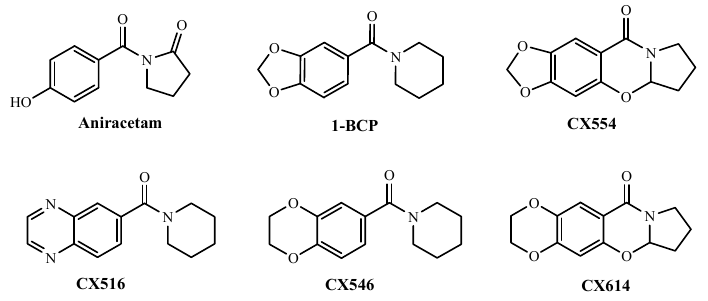
Figure 1. Chemical structures of